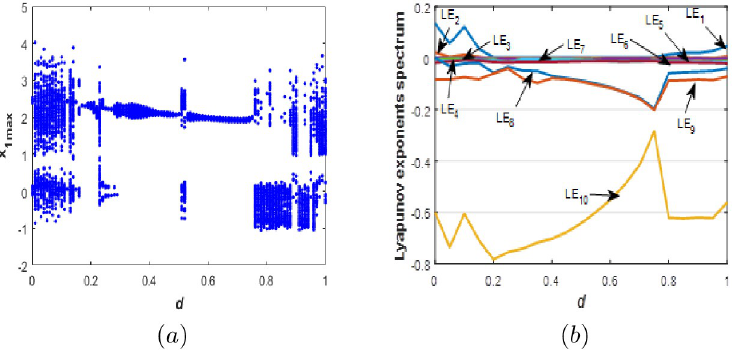
Fig 9. Bifurcation diagram (a) and Lyapunov exponents spectrum (b) of the new 10-D system (1) when: a = 0.1, b = 0.1, c = 1.8 and d 2 [0; 1].